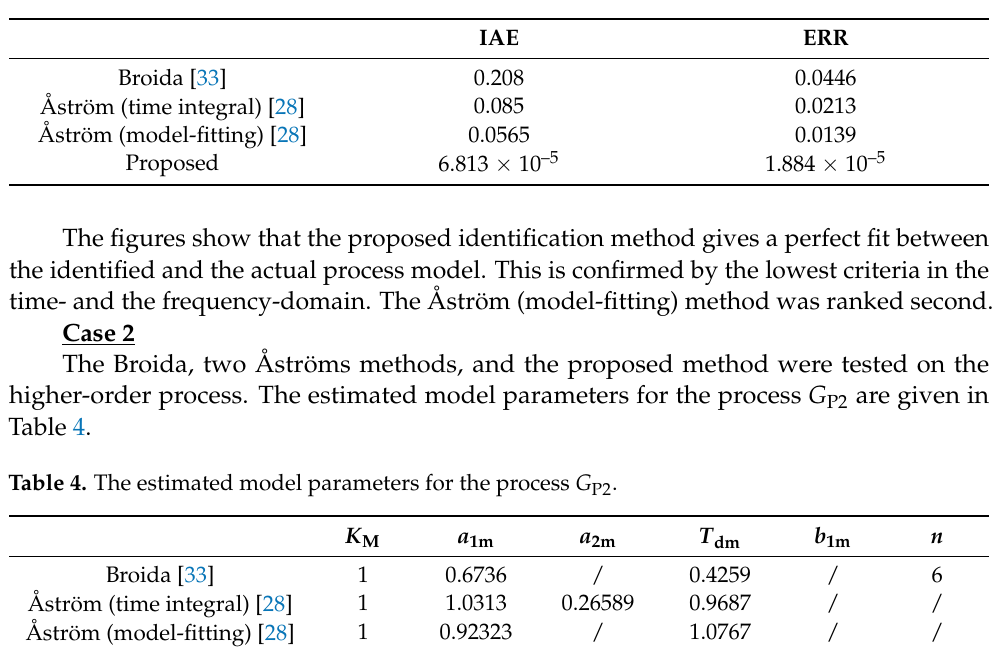
Figure 9. The Bode plots for process G P1 . Table 3. The criteria values for the process G P1 .